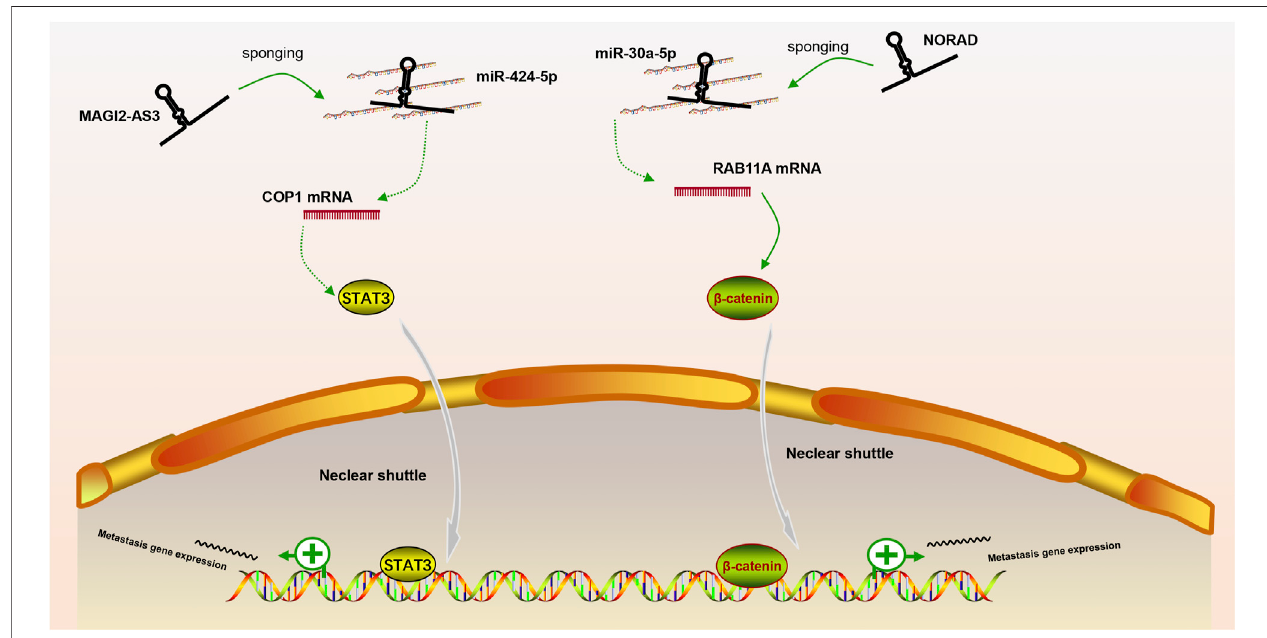
FIGURE 1 | The ceRNA network of lncRNA in regulating downstream signaling pathway. MAGI2-AS3 and NORAD regulate STAT3 or Wnt/ β -catenin signaling pathway via sponging miR-424-5p or miR-30a-5p, respectively.